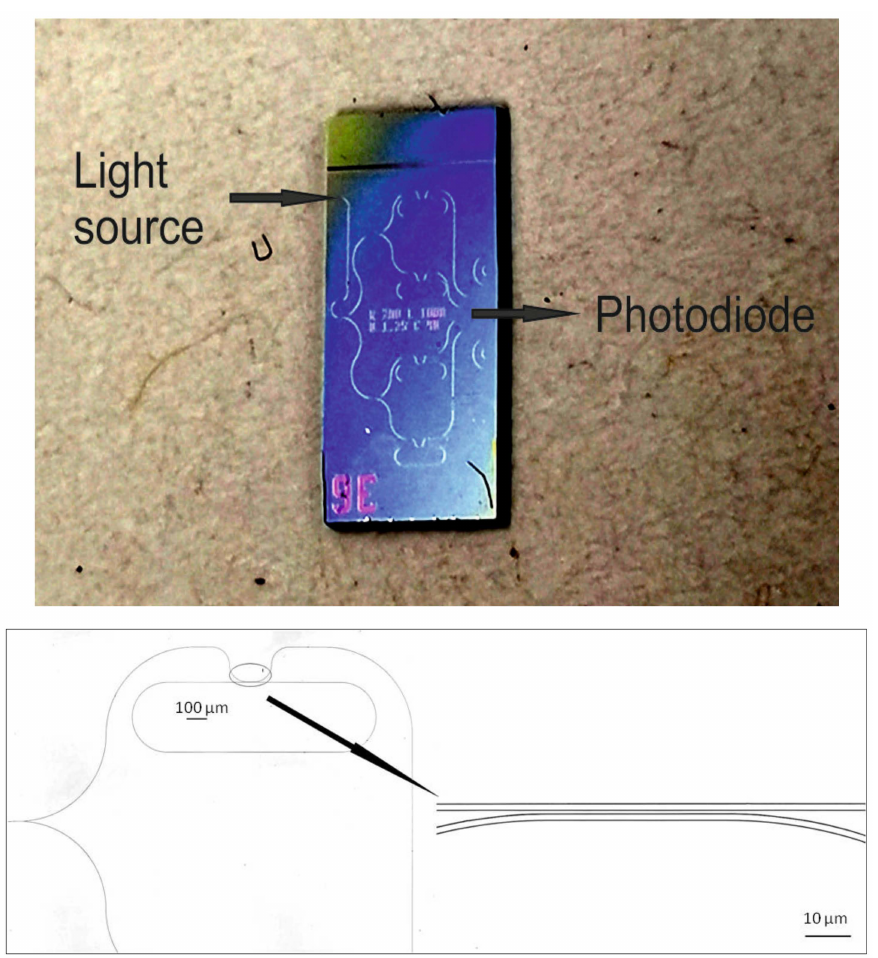
Figure 3. Photo of the complete sensor chip (top) and laser scanning microscope image of one micro-ring